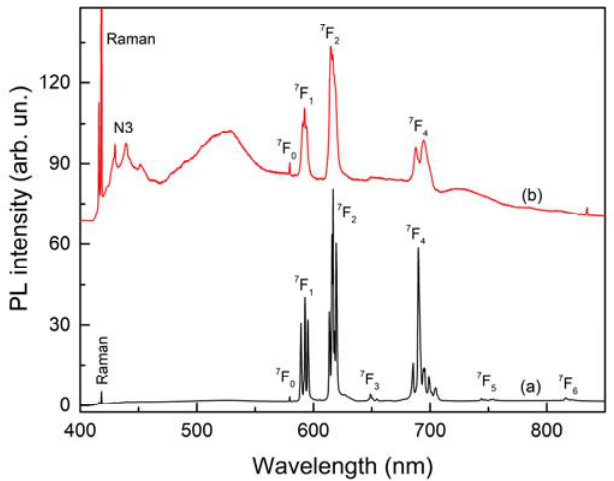
Figure 6. Photoluminescence spectra of a spontaneous diamond aggregate from run ES-8 recorded ( a ) before and ( b ) after acid cleaning. PL bands due transitions from the 5 D 0 state to different levels of the 7 F J state of the Eu 3+ ion are marked. The spectra are displaced vertically for clarity.